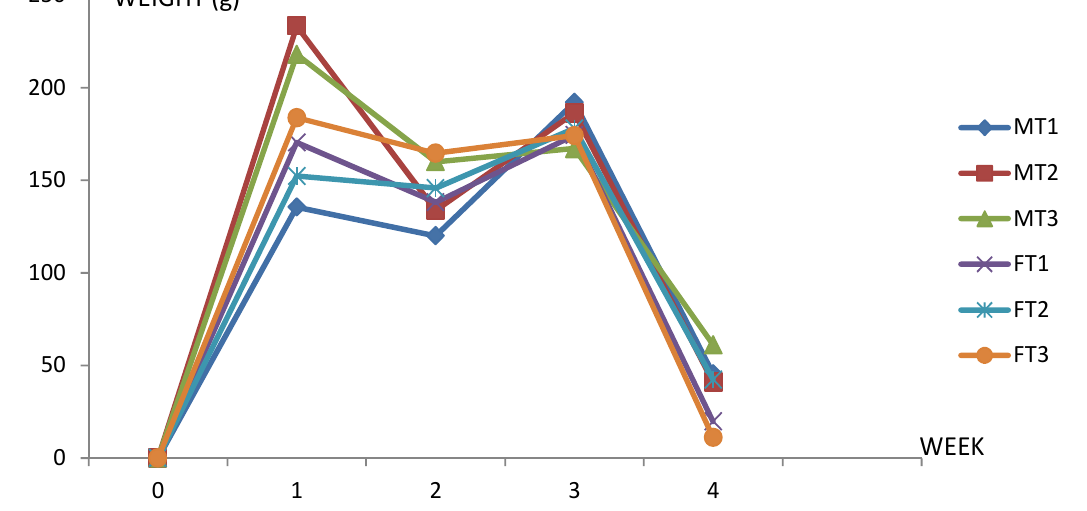
Fig. 2. Body weight gain patterns of the experimental